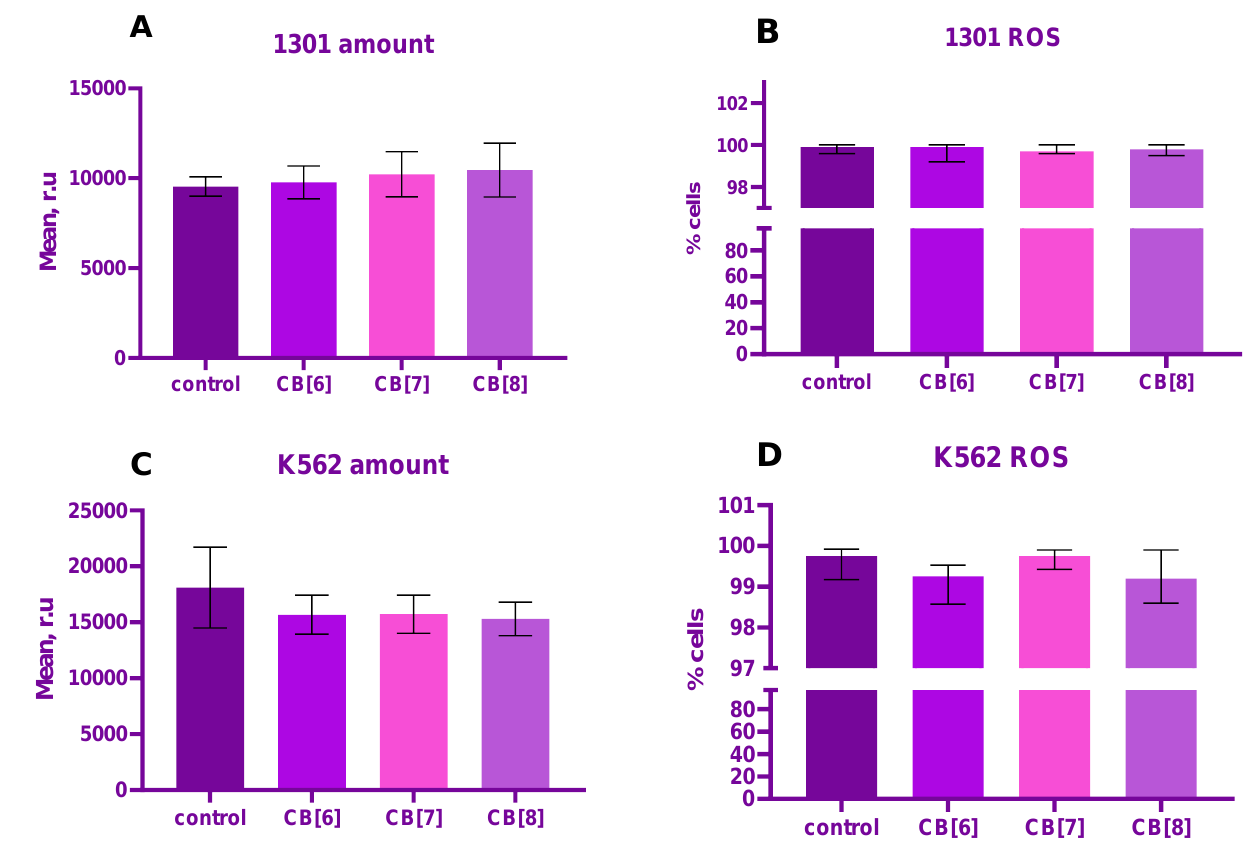
Figure 4. Graph of the amount of 1301 tumor cells ( A ) and the percentage of cells producing reactive oxygen species ( B ), Graph of the amount K562 tumor cells ( C ) and the percentage of cells producing reactive oxygen species ( D ) in response to 24-h stimulation with cucurbiturils (CB[6,7,8]). Data are median ± interquartile range (n = 6), (Kruskal–Wallis one-way analysis of variance). Notes: ( A , C )—fluorescence intensity; ( B , D )—number of ROS-producing cells among this cell’s